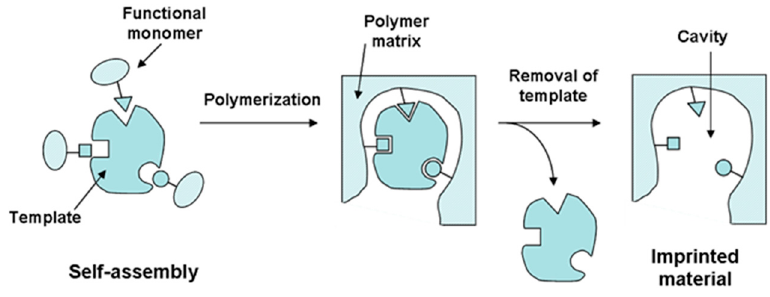
Figure 1. Schematic representation of the molecular imprinting process.